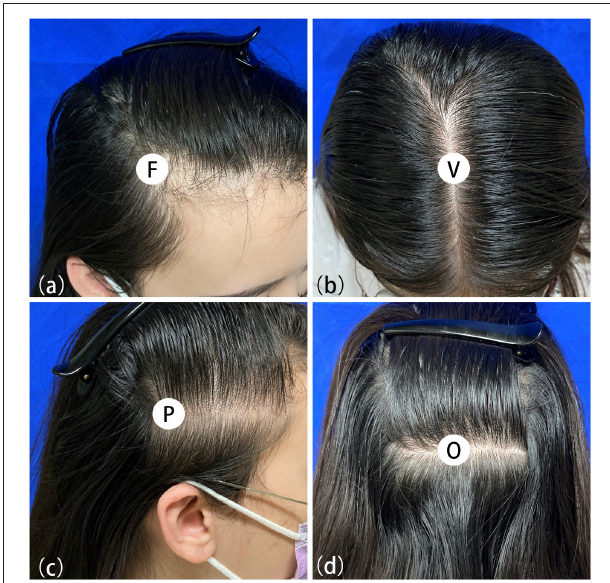
FIGURE 1 | Measuring points of trichoscopy in frontal (a) , vertex (b) , parietal (c) and occipital (d) area.